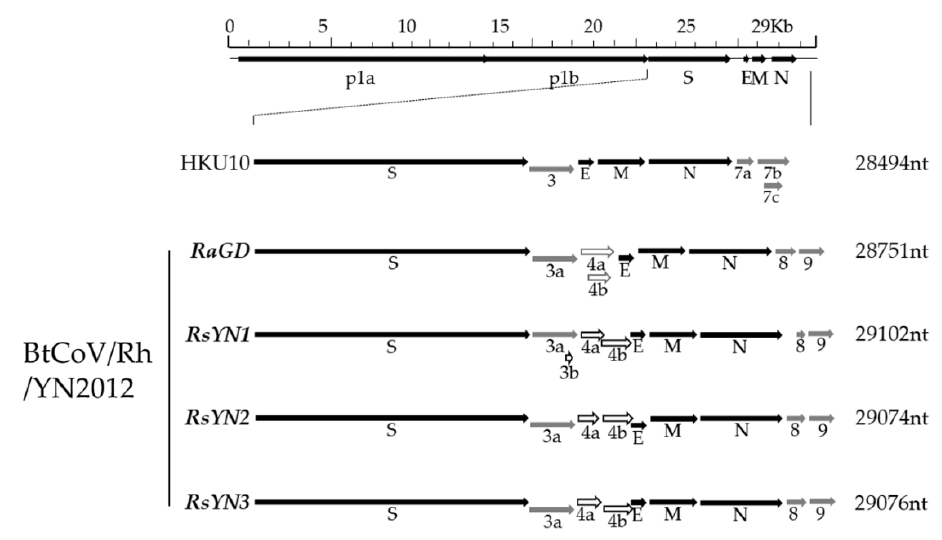
Figure 2. Schematic diagram of genomic organization of BtCoV / Rh / YN2012. The genomic regions or ORFs of BtCoV / Rh / YN2012 were compared with BatCoV HKU10. Solid bars indicate conserved genes and grey letters indicate species or group-specific genes. Hollow arrowheads indicate distinct array of accessory genes (Grey hollow arrowheads: RaGD; black hollow arrowheads: RsYN1, RsYN2, and RsYN3). Upper letters indicate structural proteins and lower letters indicate nonstructural proteins (p1a and p1b) and accessory proteins. HKU10, Ro-BatCoV HKU10. .